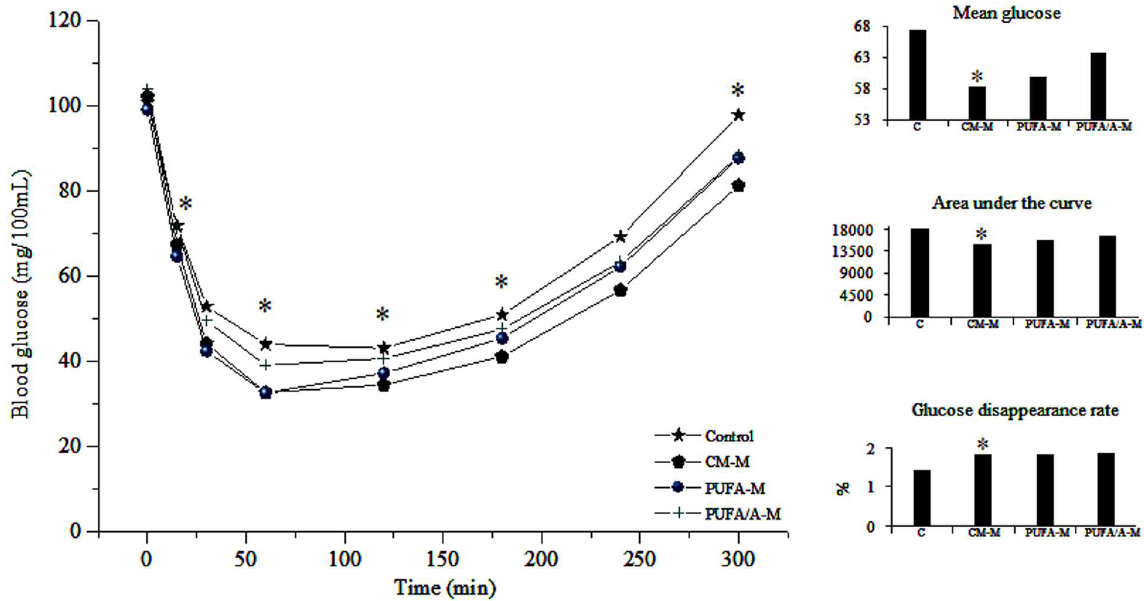
Fig 2. Glucose values in insulin tolerance test of obese rats supplemented with common milk (CM-M), milk enriched with polyunsaturated fatty acids (PUFA-M) and milk enriched with PUFA and polyphenols (PUFA/A-M). * P < 0 . 05 control vs . CM-M